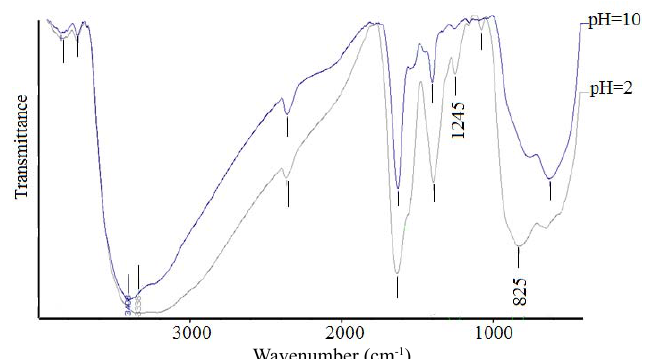
Fig. 3. FTIR spectra of CdS-TiO